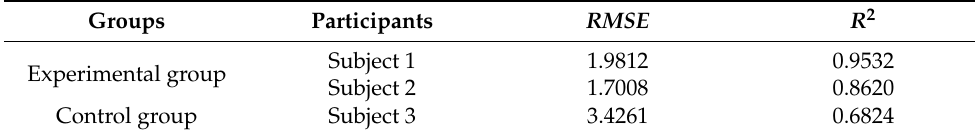
Table 1. Evaluation results of torque estimation on three subjects.